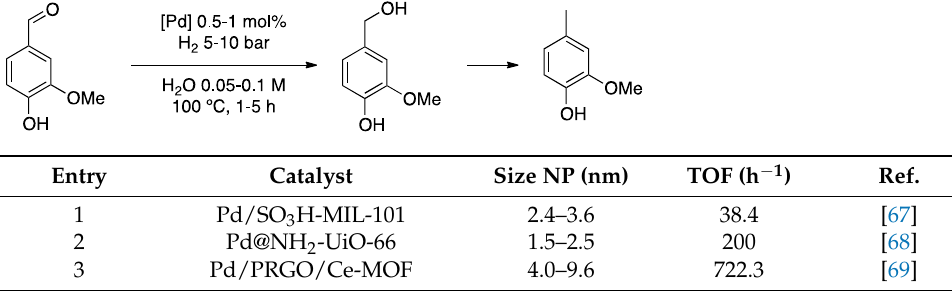
Table 3. Hydrodeoxygenation of vanillin over different catalysts.